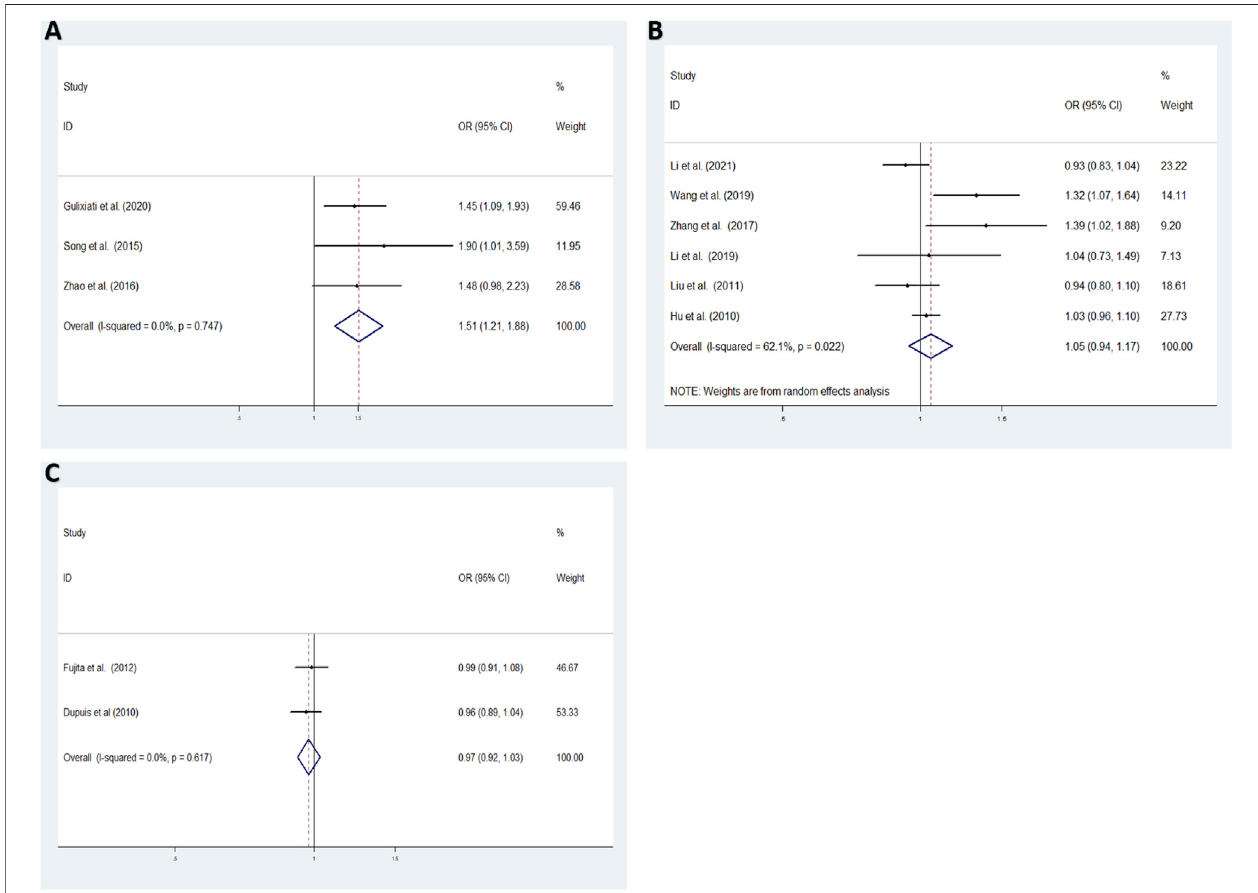
FIGURE 5 | The association between the IGF-1 rs35767 and T2DM susceptibility in the subgroup for the allele model (T vs. C) (A) XinJiang , China ( fi xed effects model) (B) Other provinces , China (random effects model) (C) Other countries ( fi xed effects model). OR: odds ratio, CI: con fi dence interval, I-squared: measure to quantify the degree of heterogeneity in